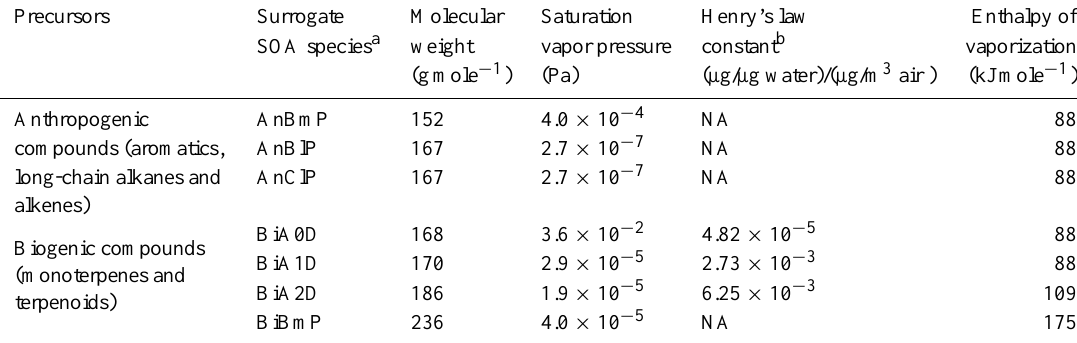
Table 1. Surrogate SOA compounds, their corresponding precursors and their physico-chemical properties. Precursors Surrogate Molecular Saturation Henry’s law Enthalpy of SOA species a weight vapor pressure constant b